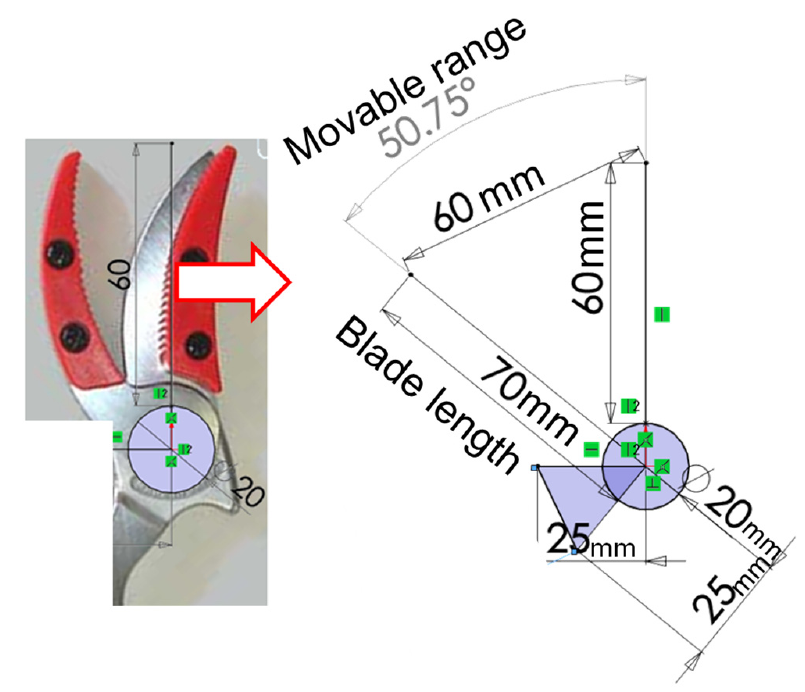
Figure 9. A mechanical model of a pruning scissor.